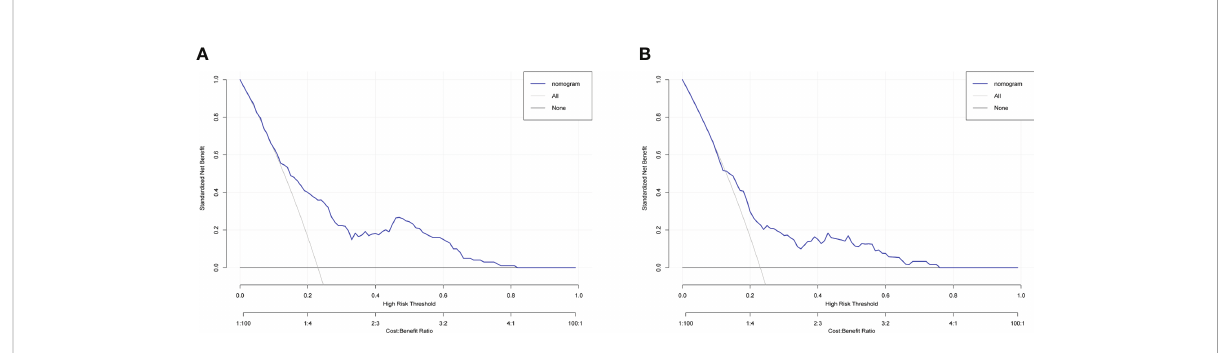
FIGURE 7 Decision curve analysis for the nomogram in predicting NSLN metastasis in the training cohort (A) and validation cohort (B)